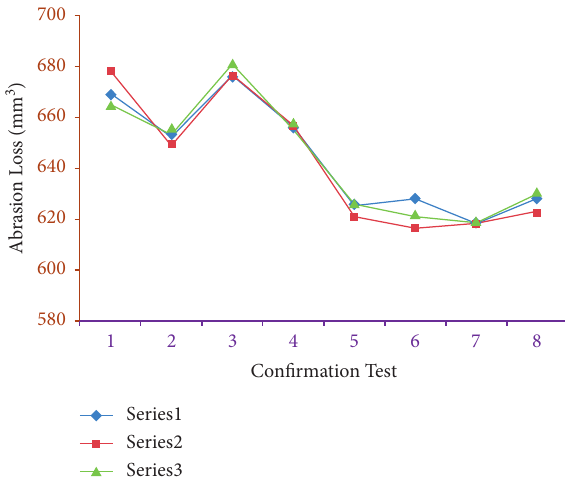
Figure 10: Comparison of predicted and experimental abrasion loss values.